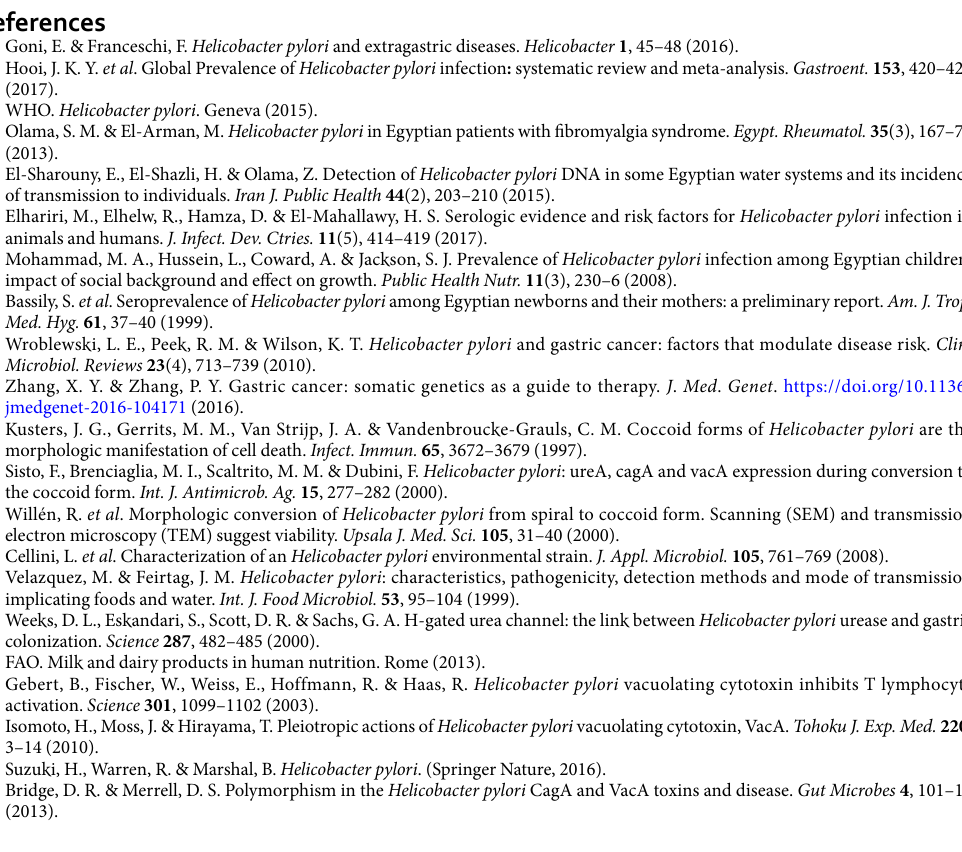
to six 10-fold serial dilution containing 10 1 − 10 6 fg bacteria (10 fg corresponds to 5 bacterial cells per 200 ng of host’s DNA) 66,67 . Each dilution was added to 200 ng genomic DNA extracted from uninfected gastric mucosa and was amplified in parallel with the samples. The standard curve was generated by plotting the amount of bacterial DNA in the dilution series against the corresponding Ct cycle number, (Fig. S5). The concentrations of H . Pylori DNA in the tested samples was determined by interpolation of the corresponding Ct value from the standard curve. The bacterial load is expressed as cell numbers per 200 ng mouse genomic DNA. Detection of mRNA expression of vacA and cagA by reverse transcription polymerase chain reaction (RT-PCR). RNA was extracted from the UHT milk samples and mouse gastric mucosa using the RNeasy mini kit (Qiagen) with DNase treatment step using RNase-free DNase set (Qiagen). The concentration of the extracted RNA was measured by Qubit ® 2.0 Fluorometer (Thermo Fisher Scientific). Reverse transcription (RT) and Uniplex-PCR targeting cagA and vacA alleles were carried out in a single step using OneStep RT-PCR Kit (Qiagen). The extracted RNA (1 μ g) was mixed with the RT-PCR kit reagents according to the recommen- dation of the supplier. The primers targeting cagA , vacA alleles, and H . pylori -specific 16s rRNA genes (Table 1) were added separately to the reaction mixture. The H . pylori -specific 16s rRNA was used as a control to exclude the presence of PCR inhibitors in the samples. The RT-PCR reactions were cycled in the Swift MiniPro Thermal Cycler (ESCO Technologies Inc.) under two steps. The first step is the cDNA synthesis by incubation at 70 °C for 50 min, then at 94 °C for 2 min; the second step is amplification of the synthesized cDNA through 10 PCR cycles of denaturation at 94 °C for 30s, annealing at 60 °C for 30s, and extension at 70 °C for 1 min. This was followed by 25 cycles of denaturation at 94 °C for 1 min, annealing at 60 °C for 1 min, and extension at 70 °C for 1 min with a final extension of 7 min at 70 °C. The RT-PCR products were detected by 1.5% agarose gel electrophoresis con- taining 0.5x TBE at 70 volts for 60 min and visualized using a UV transilluminator (IN Geniuse 3, Syngene, MD, USA) connected with Quantity-one 4.6.2 software image for capture and analysis. The 100 bp DNA ladder marker (Size range: 100–1,000 bp, Jena Bioscience GmbH) was run simultaneously. Statistical analysis. (Table 2). McNemar test was used to compare the occurrence of H . pylori between milk and fecal samples (Table 2). Repeated Measures ANOVA was used to examine the influence as well as the interaction of the fac- tors, temperature [4 °C, 37 °C, and 40 °C] and time periods of storage [1–30 days] on the count of the SVCF and CVNCF of H . pylori (Fig. 5). On each occasion, P values ≤ 0.05 were regarded as significant. Data Availability Statement All data generated or analyzed during this study are included in this published article (and its Supplementary Information